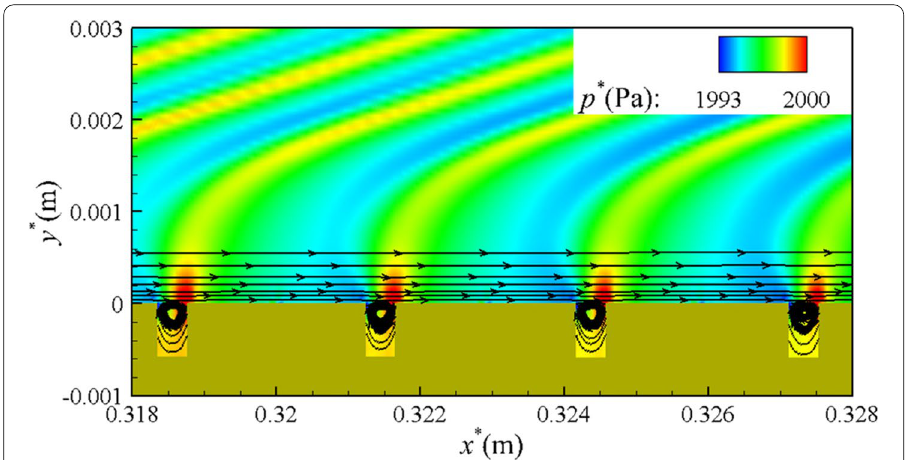
Fig. 10 Local pressure contour around the cavities of the broadband acoustic